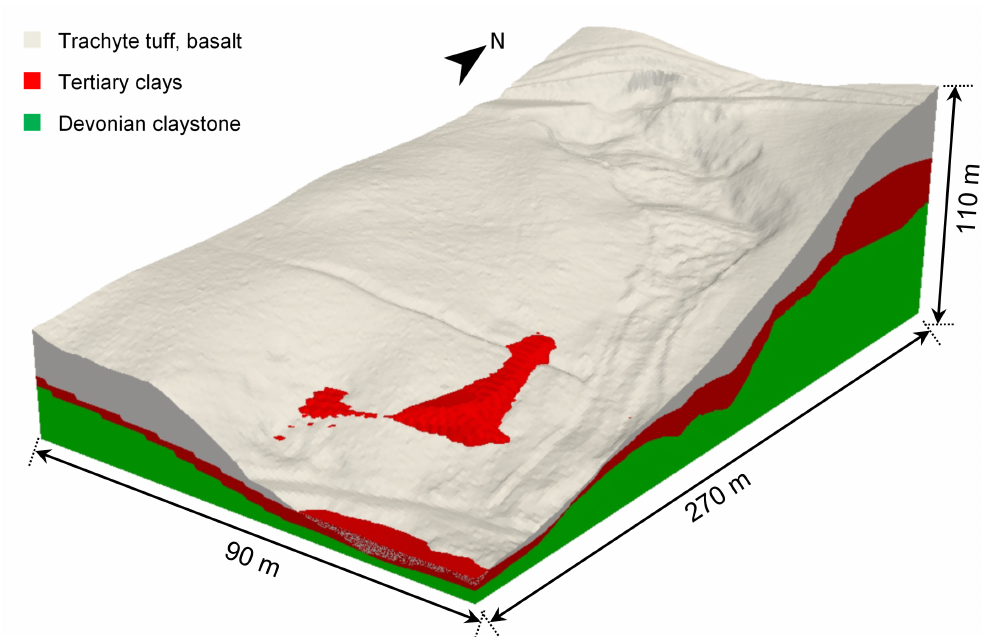
Figure 7. Derived 3D geological model based on refraction seismic survey and borehole logs. Digital elevation model provided by Geobasisdatendienst